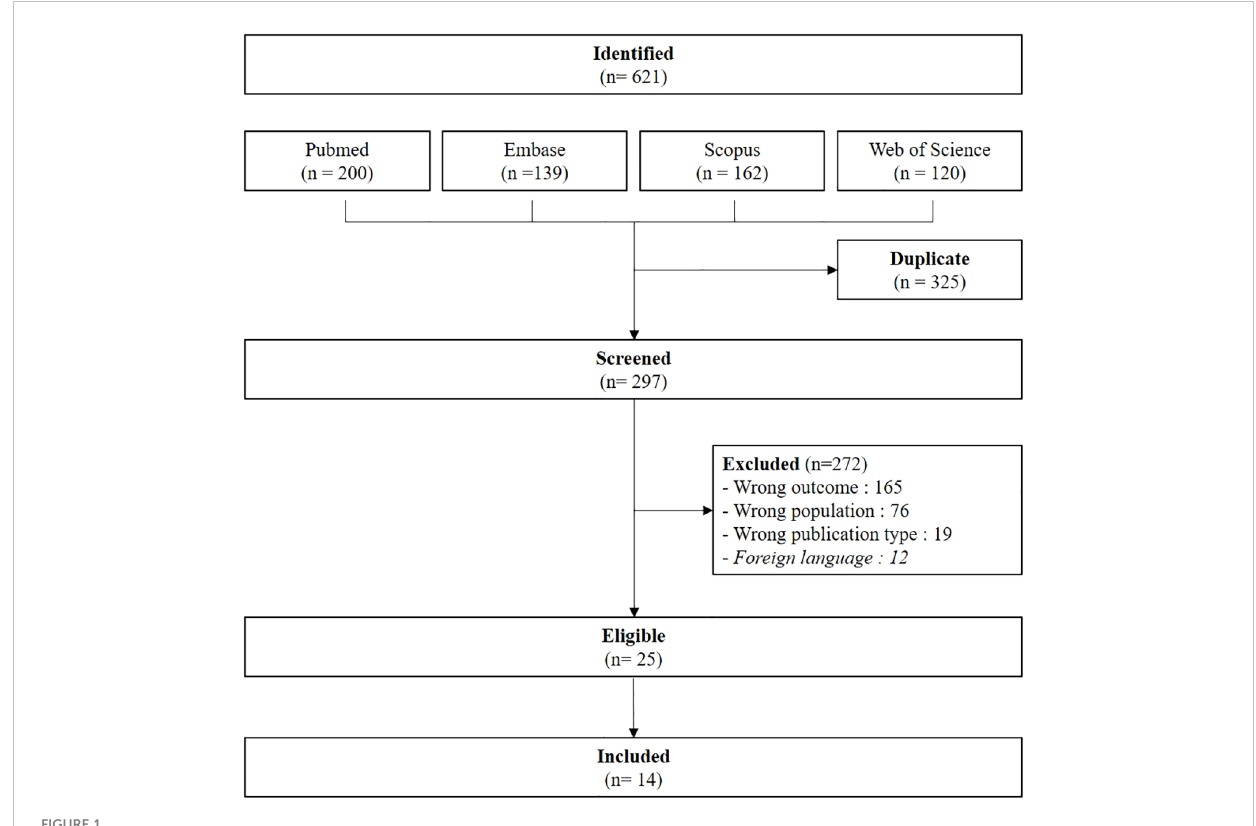
FIGURE 1 Flowchart of the literature search and selection